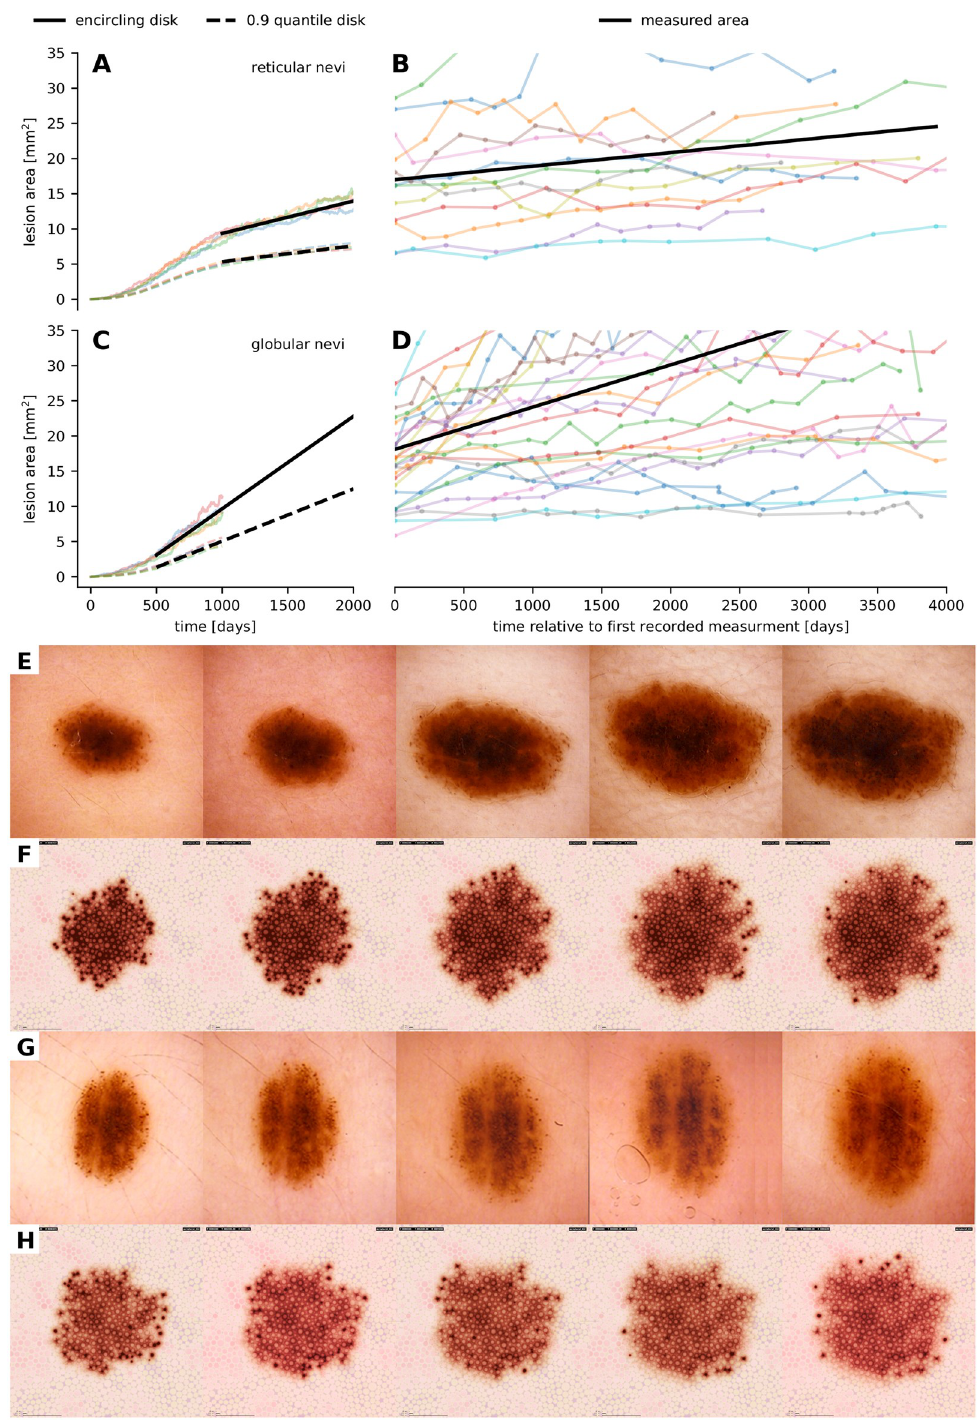
Fig 6. Comparison of the growth dynamics of nevi as documented in clinical imagery and generated by our model. (A, B, C, D) Comparison of the spatio-temporal evolution of the areal size of four simulated reticular (A) and globular (C) nevi as well as 13 reticular (B) nevi and 25 globular (D) nevi that were retrieved retrospectively from collected anonymized sets of digital dermatoscopic images. We used linear interpolation to quantify the growth dynamics in silico and in vivo. Black lines show the averaged linear growth dynamics. (E, F, G, H) Temporal evolution of the dermatoscopic exposition of real (E, G) and simulated (F, H) nevi with a peripheral rim of globules. Dissolving melanocytic nests in the center region yield